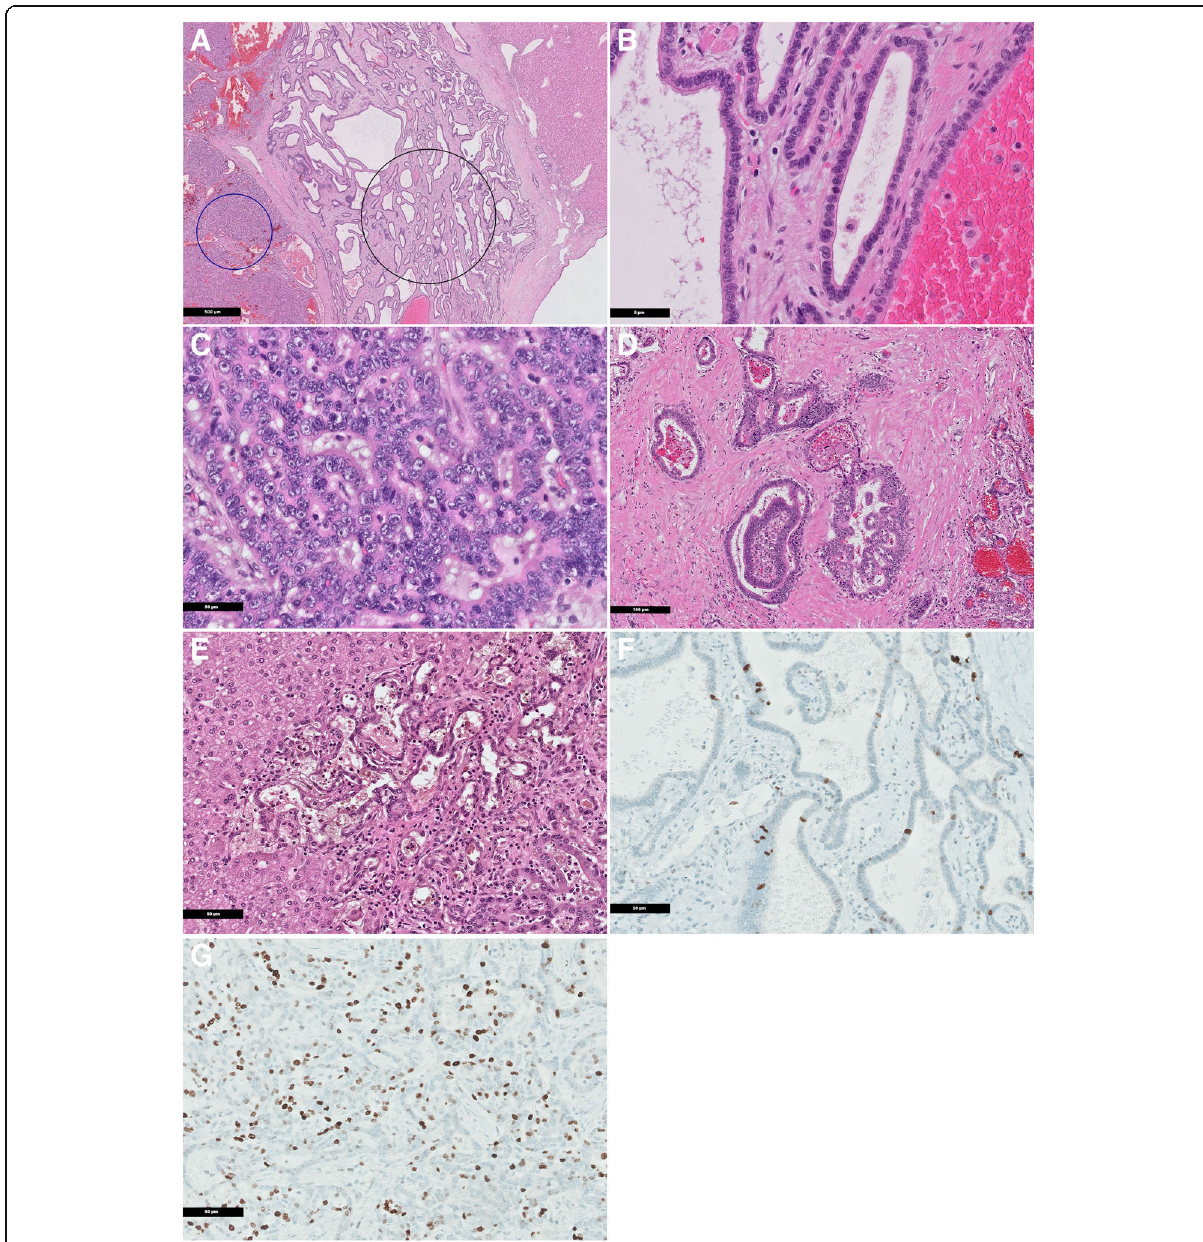
Fig. 3 a Microscopic findings of the tumor. Low magnification shows crowded, back-to-back tubulare structures (left side; adenocarcinoma) and parts of tubulocystic formations embedded in dense fibrous stroma (center; biliary adenofibroma) with adjacent normal liver parenchym (right side) (H&E × 20). The black circle indicates the bengin part of tumor (bililary adenofibroma) and the blue circle the malignant part of tumor (adenocarcinoma). These two different parts of tumor were marked on the histological slide for subsequent dissection. b At higher magnification, the cysts lined by a bland cuboidal single layer to columnar epithelium of the biliary phenotype with uniform nuclei without feature of malignancy; biliary adenofibroma (H&E ×400). c The areas of macroscopically solid appearance shows irregular pattern with crowded, anastomosing tubules. The nuclei closely packed, pseudostratified with heterogeneously distributed chromatin and prominent nucleoli; adenocarcinoma (H&E ×400). d Focal, the neoplasm shows a complex architecture, composed of pseudopapillary and cribriform-like tubules in a dense stroma; adenocarcinoma (H&E ×100). e In the peripheral area reveals irregularly glandular structures infiltrate the adjacent liver parenchyma; adenocarcinoma (H&E ×200). f Ki67 proliferation index in benign part of the tumor (biliary adenofibroma) less than 10 % (Ki67 staining ×200). g Ki67 proliferation index in the malignant part of the tumor (adenocarcinoma) significantly increased to 20 – 30 % (Ki67 staining